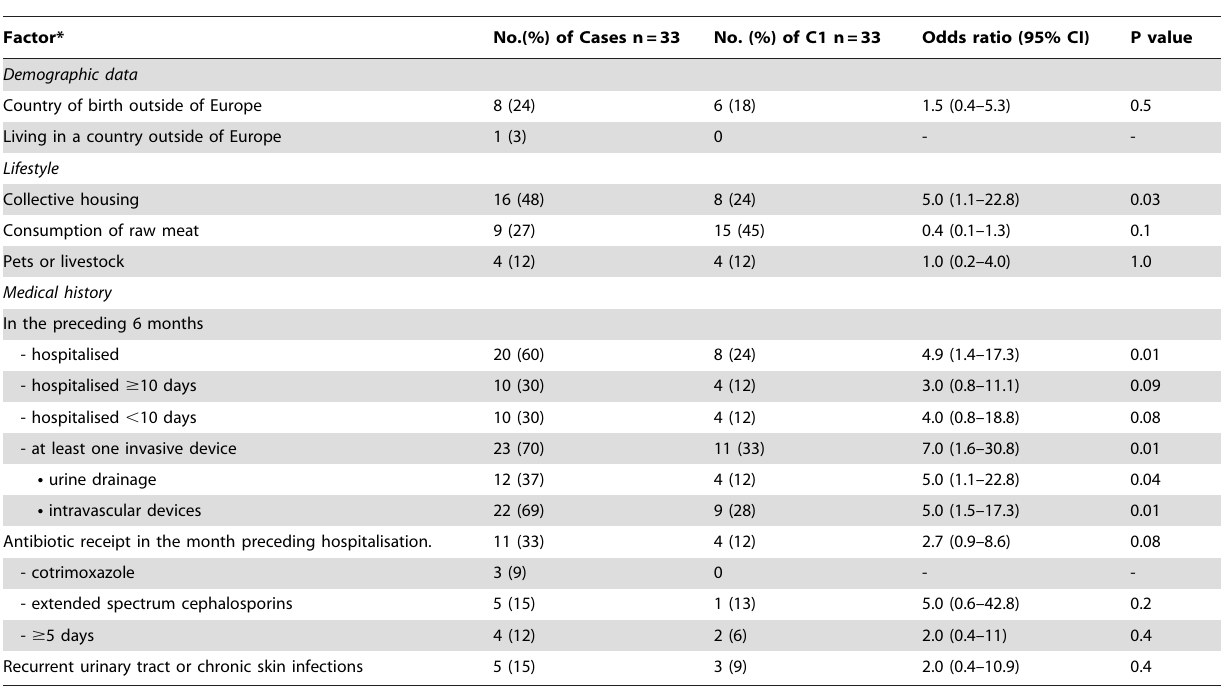
Table 5. Univariate analysis of factors associated with a CTX-M producing E. coli clinical isolates within the first 48 h of hospitalisation in subpopulations of cases (patients with a CTX-M producing E. coli isolate) and controls (C1: patients with a non- ESBL producing E. coli